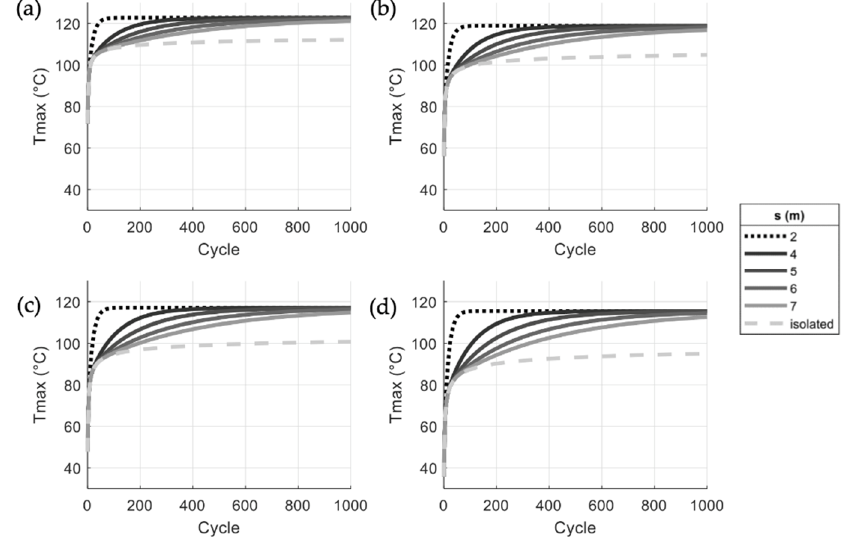
Figure 9. The largest temperature ever reached in each cycle for various s at ( a ) the one-third location; ( b ) the middle location; ( c ) the two-thirds location; and ( d ) the outer surface of the pile section.